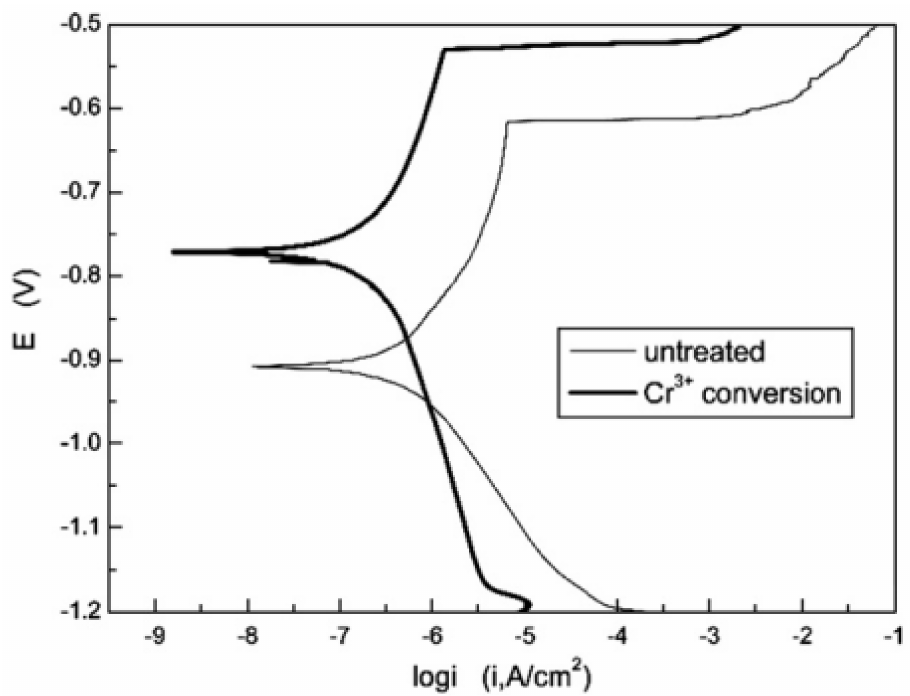
Figure 9. Polarization curves of the 6063 Al alloy without and with Cr 3+ surface treatment in 3.5% NaCl solution at room temperature. Reprinted with permission from Ref. [30]. Copyright 2008,